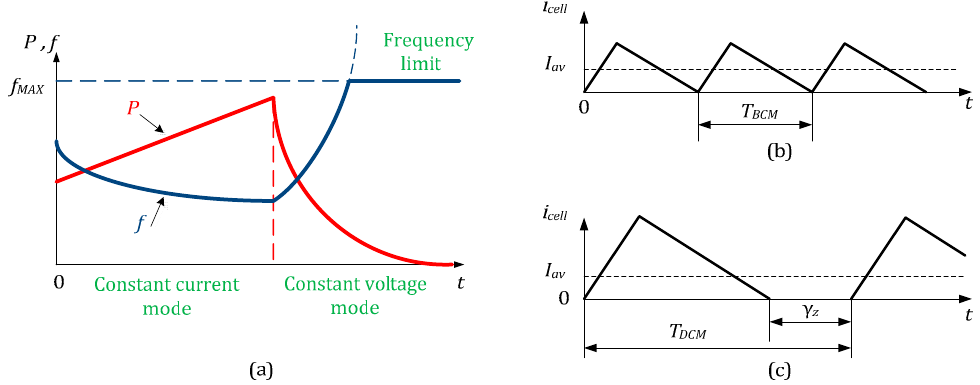
Figure 13. Generalized charging process with frequency limitation in constant voltage operating mode ( a ); average current (power) regulation principle: Boundary conduction mode (BCM) ( b ) and DCM ( c ).